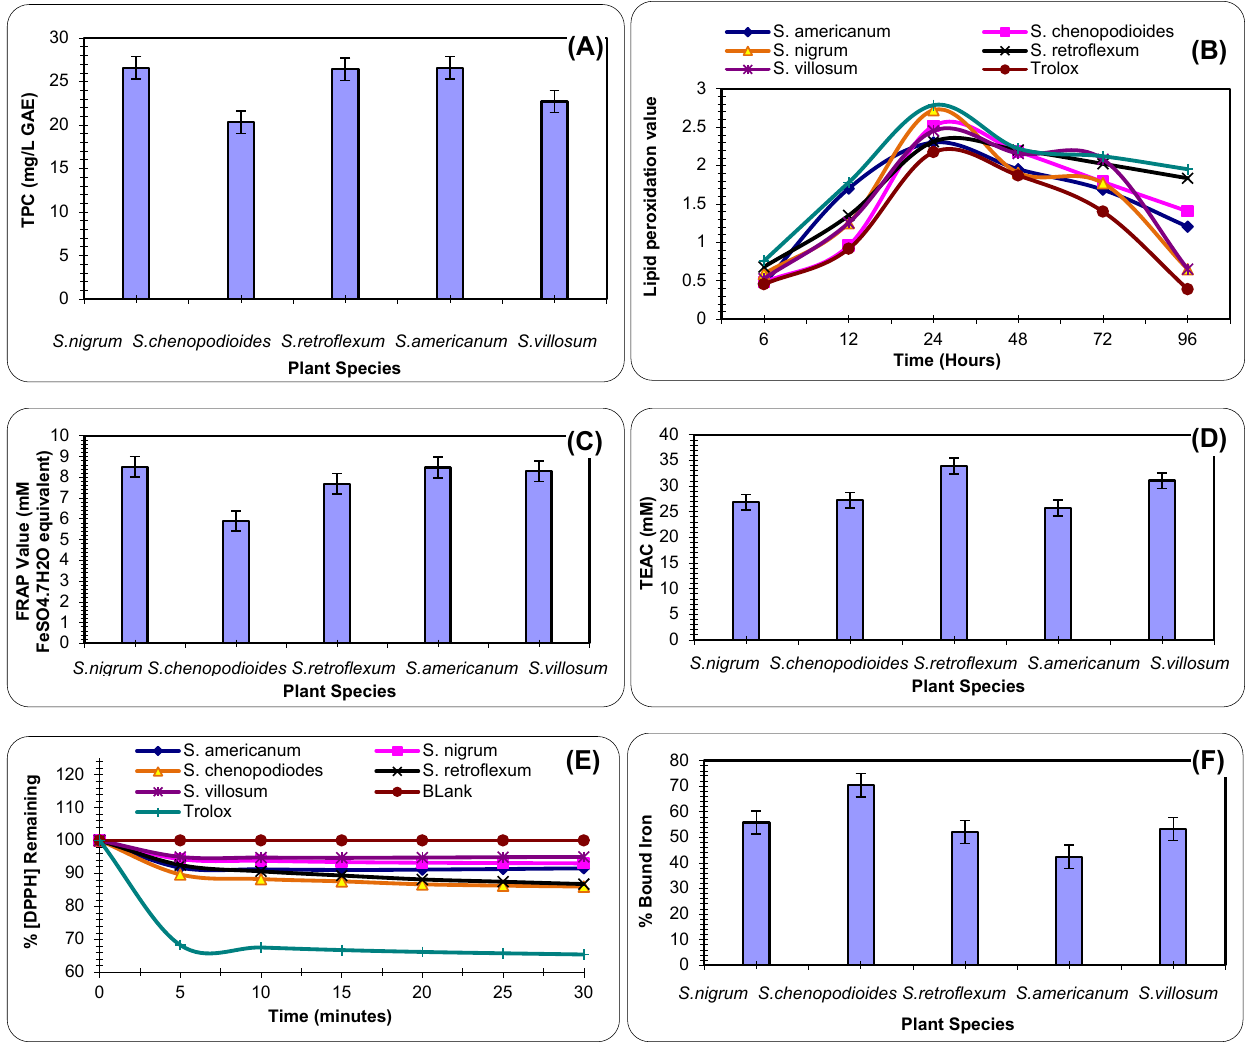
Figure 1. Antioxidant potential of five taxa of the S. nigrum complex: ( A ) total phenolic